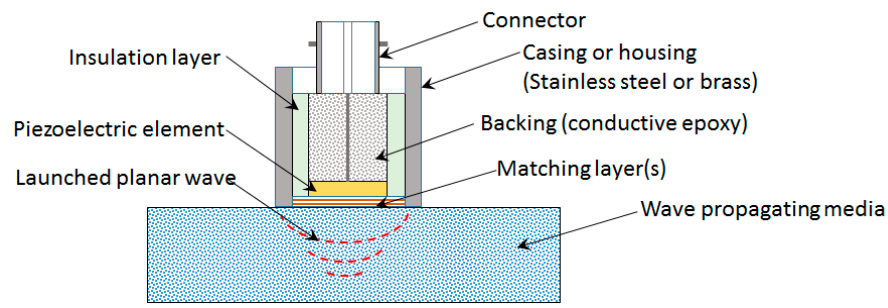
Figure 5. Schematic of a piezoelectric ultrasonic transducer cross-section showing various parts.